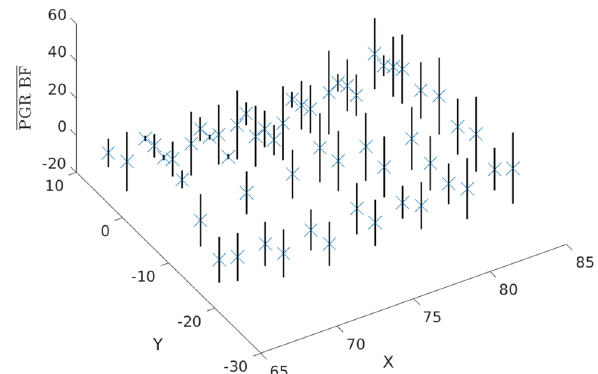
Fig. 18 PGR ( 𝐩 i ) and PGR s ( 𝐩 i ) , where poses consider only variations in the X-Y-Z plane, so 𝐩 i ∈ ℝ 3